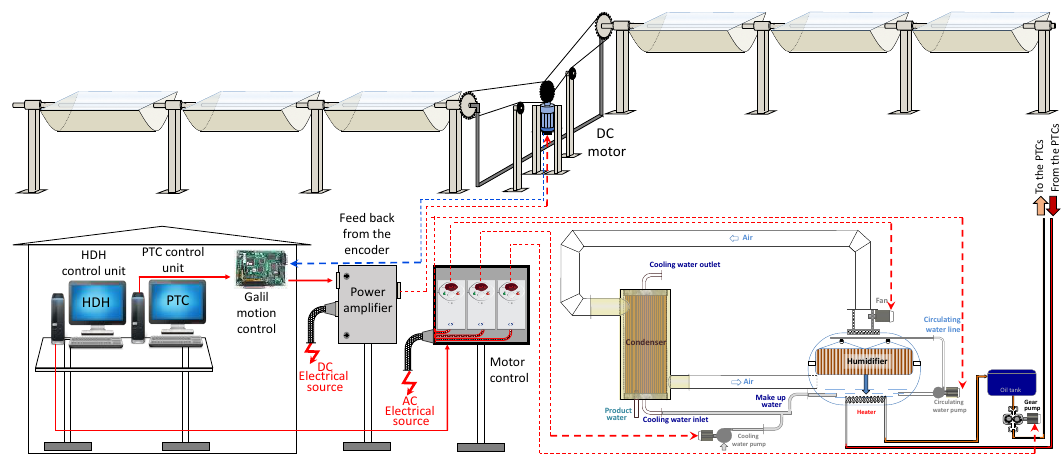
Figure 7. Schematic diagram of the experiment controls.